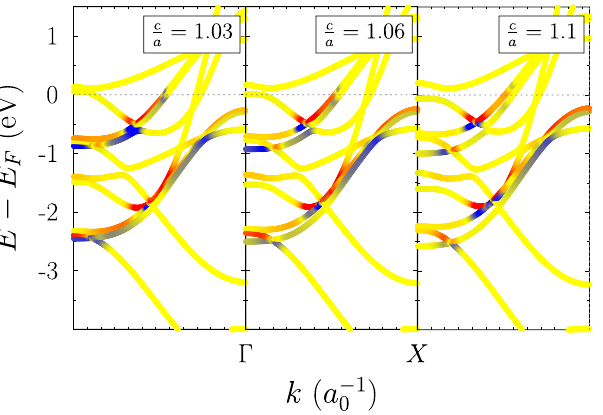
Figure 5. Moment of inertia in the electron band structure for bulk fcc Co strained along the z axis. The magnetic moment is also in z direction. The colour and the intensity indicates the sign and value of the inertia contribution (blue − ι < 0; red − ι > 0; yellow − ι ≈ 0 ). The dotted grey line is the Fermi energy and Γ is 0.1 eV. Note that we analyse for simplicity and clarity only one contribution, A n B m , in the expression for V nm . The integrated moment of inertia is ι = 4.78 · 10 − 4 fs, ι = 4.88 · 10 − 4 fs, and ι = 5.31 · 10 − 4 fs for c / a = 1.03, c / a = 1.06, and c / a = 1.1,